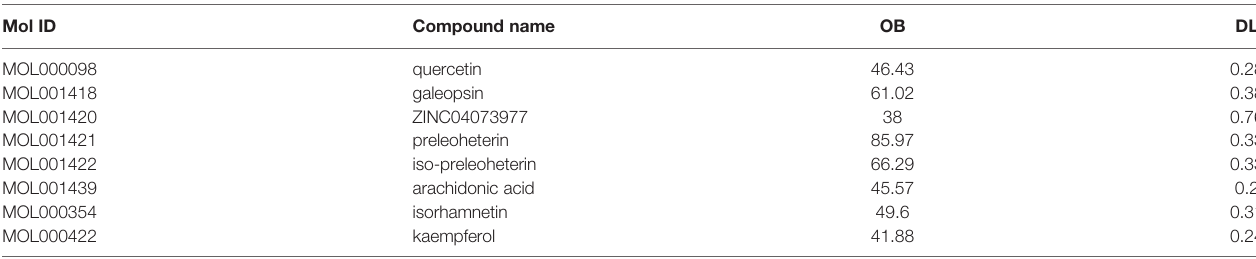
OB, oral bioavailability; DL,